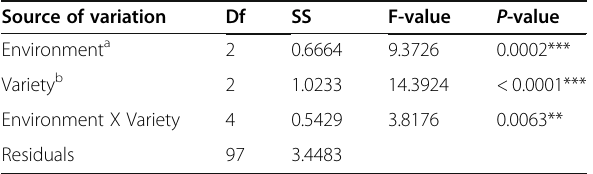
Table 4 Two-way ANOVA on the day 9 survival rate of N. lugens nymphs feeding on IR24, NIL- BPH17 and NIL- BPH20 responses to